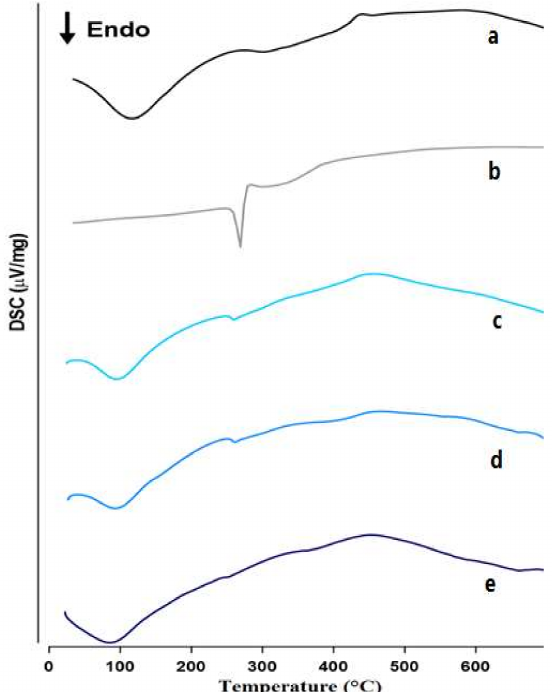
Figure 2. DSC thermograms of following: ( a ) sulfonatocalix[4]naphthalene (C), ( b ) meloxicam (ME),